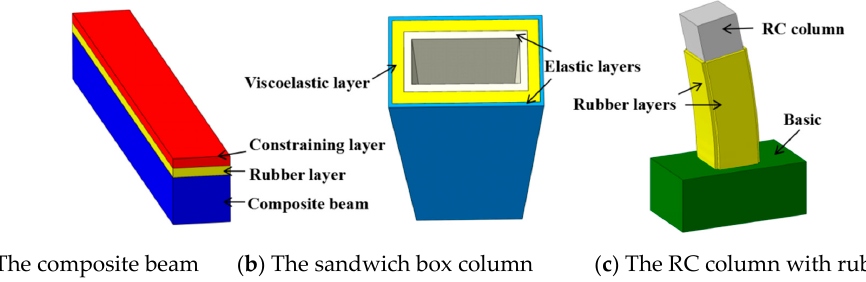
Figure 1. Types of composite structures with rubber layers including reinforced concrete (RC).